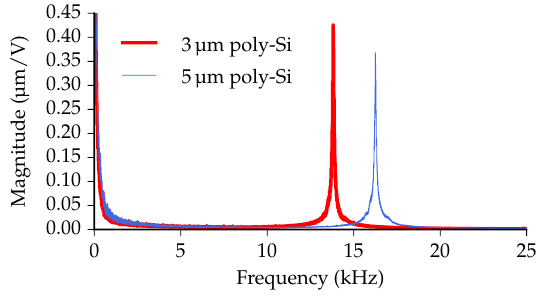
Figure 15. The frequency response of the positionable waveguide arrays from 0kHz to 25kHz. The measured resonance peaks are at 13.8kHz and